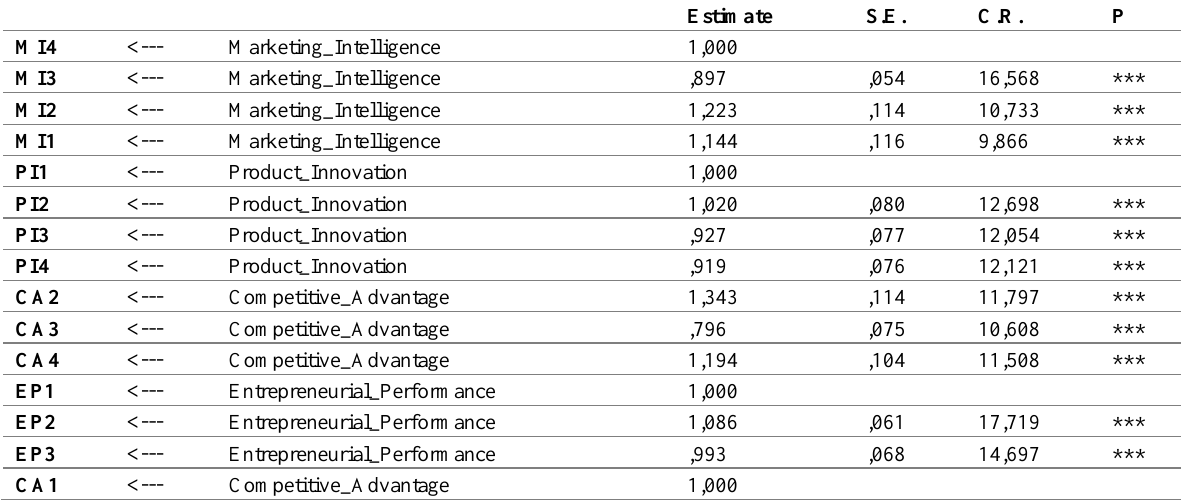
Table 7: Regression Weights on Factor